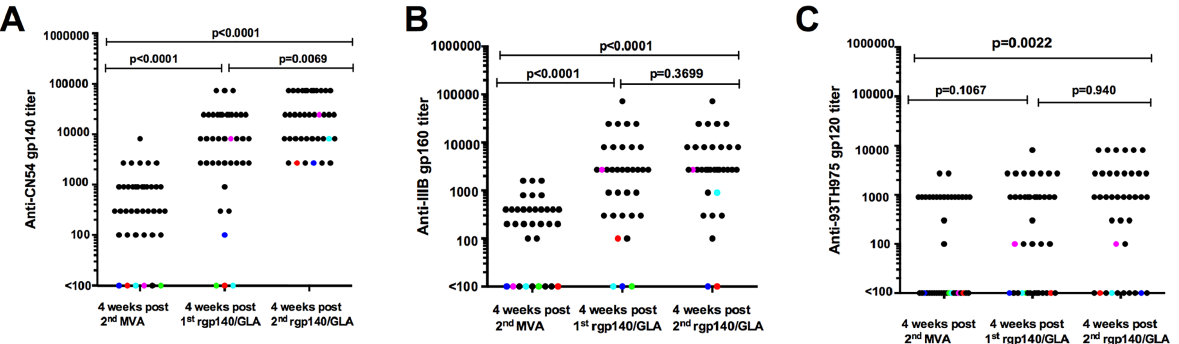
Fig 2. Binding antibody responses to three subtype antigens. Antibodies to A) subtype C CN54rgp140, B) subtype B gp160 and C) CRF01_AE gp120 were determined at three time points; four weeks after three HIV-DNA and two HIV-MVA vaccinations, and four weeks after the first and second CN54rgp140/GLA-AF immunization. Black dots show vaccinees who received 7 vaccinations, while colored dots show unprimed vaccinees who received two CN54rgp140/GLA-AF immunizations only. The Mann-Whitney test was used for statistical